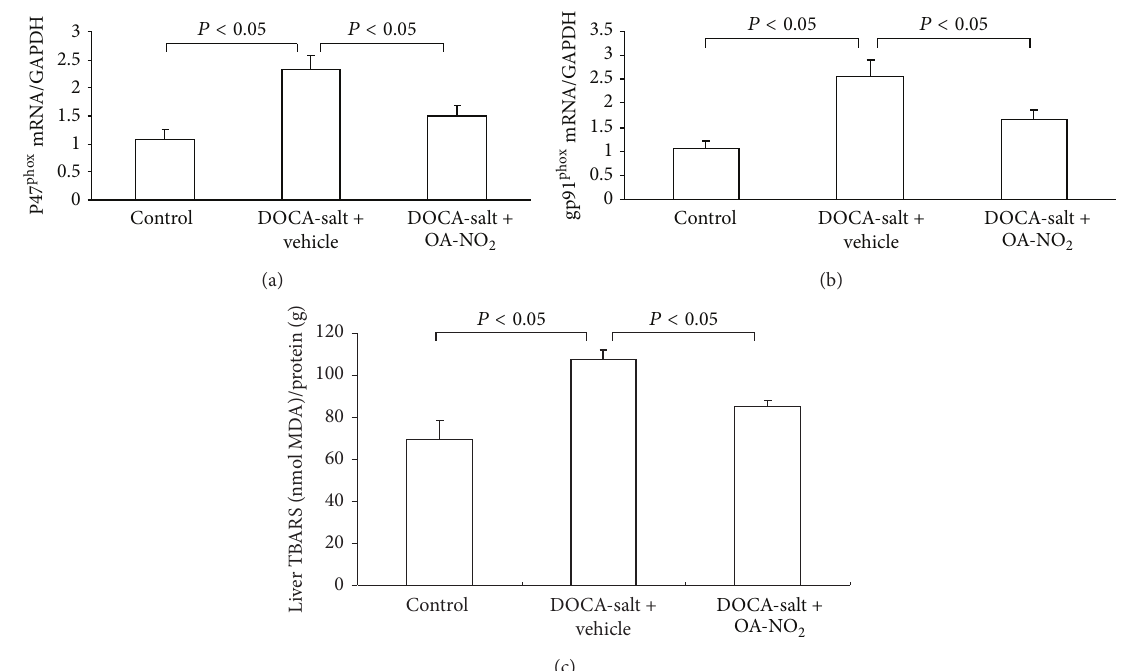
Figure 6: Effect of OA-NO 2 on the oxidative stress after 3-week DOCA-salt treatment. Liver p 47 phox mRNA expression (a) and gp 91 phox mRNA expression, and the liver TBARS content (c) in control ( 𝑛 = 5 ), DOCA-salt + vehicle ( 𝑛 = 8 ), and DOCA-salt + OA-NO 2 ( 𝑛 = 8 ) mice. Data are shown as mean +